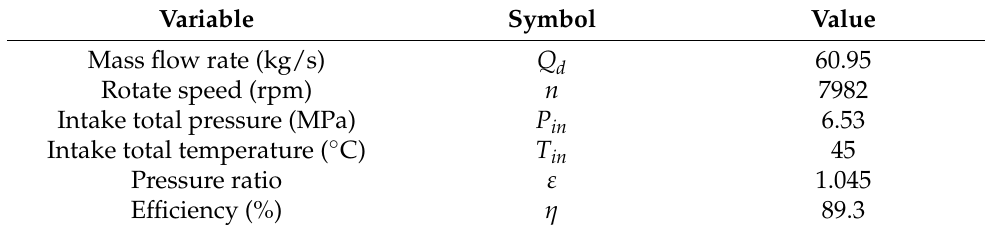
Table 3. Compressor performance at design